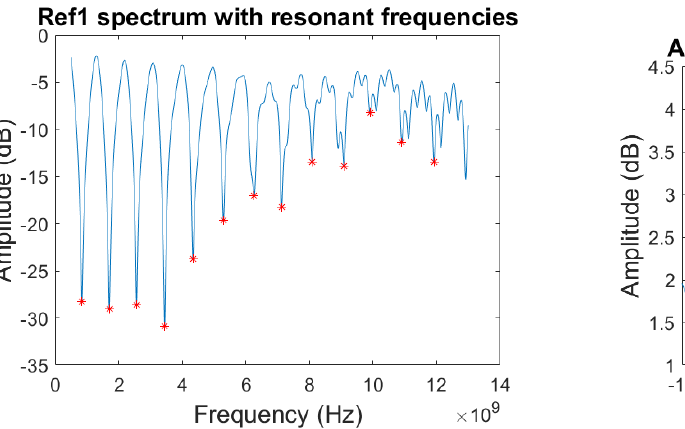
Figure 3. Edge effects in SMM